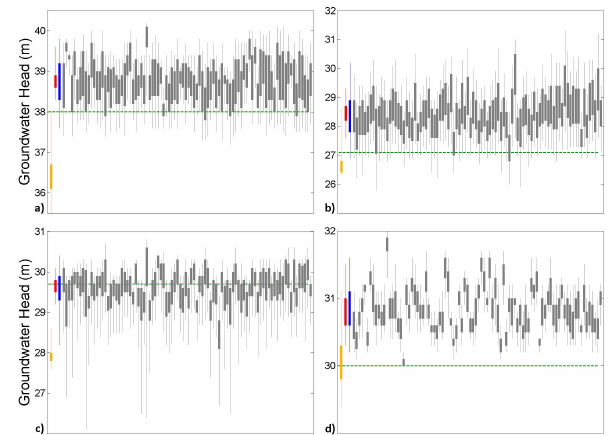
Fig. 11. Boxplot of simulated groundwater head at four selected observation points: (a) Obs10, (b) Obs34, (c) Obs50, (d) Obs57. The dashed green line is the observed groundwater head, the yel- low color plots represent 90 simulations from GeoModel-I, the red color plots represent 90 simulations from GeoModel-II, the blue color plots represent GeoParModel, and the gray color plots rep- resent simulations of the individual ParModels, each consisting of 216 simulations. The edges of the boxes are the 25th and 75th per- centiles, and the whiskers extend to the 2.5th and 97.5th percentiles (values are listed in Table